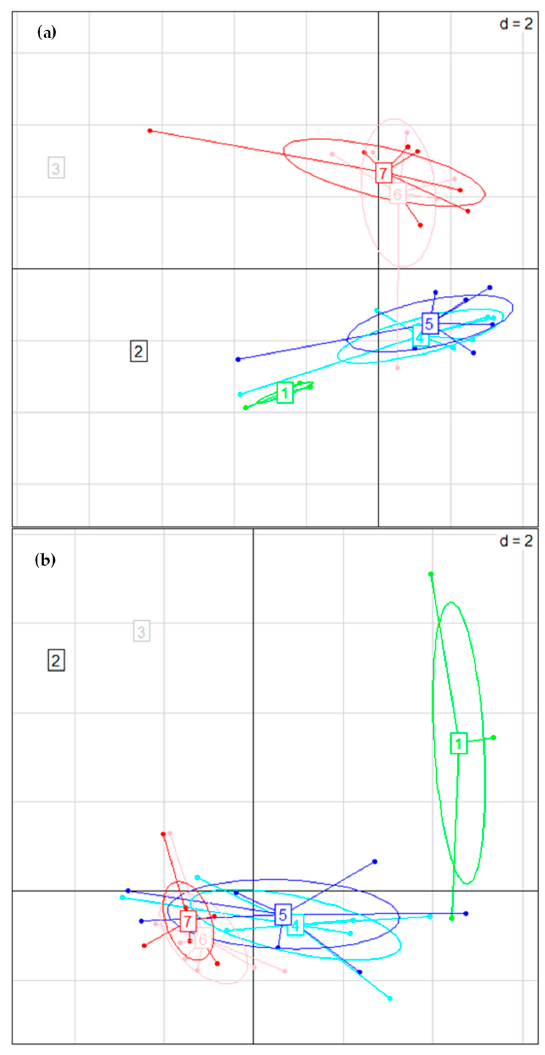
Figure 5. Principal component analysis (PCA) based on amplicon sequence variant (ASV) relative frequencies of thistle-based coagulants, raw milk, and Caciofiore cheeses for bacterial biota (panel ( a )) and mycobiota (panel ( b )). Samples are coded as follows: 1-green, coagulants; 2-black, milk used in round 1 (R1_M); 3-gray, milk used in round 2 (R2_M); 4-cyan, cheese manufactured with commercial coagulant (Cc) in R1; 5-blue, cheese manufactured with coagulant obtained from spontaneous O. tauricum flowers (CE_st) in R1; 6-pink, cheese manufactured with commercial coagulant (Cc) in round 2; 7-red, cheese manufactured with coagulant obtained from O. tauricum cultivated flowers (CE_st) in R2.